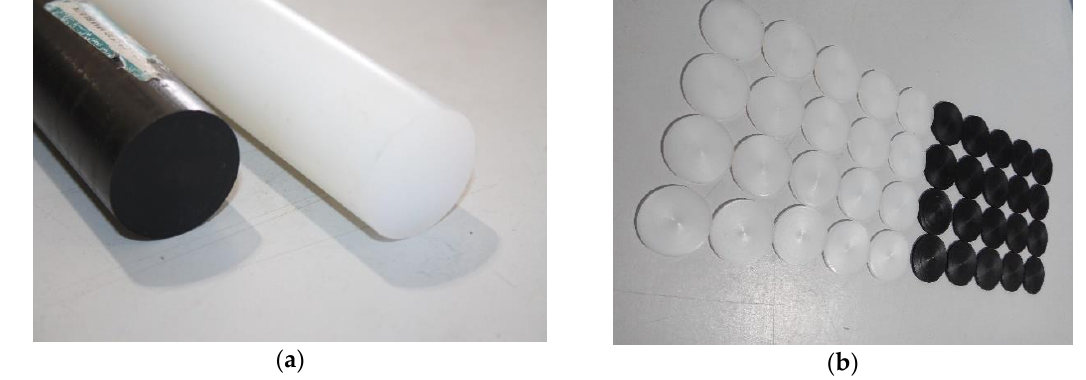
Figure 1. White and black Ertalon 6 SA: ( a ) rods; ( b ) discs.